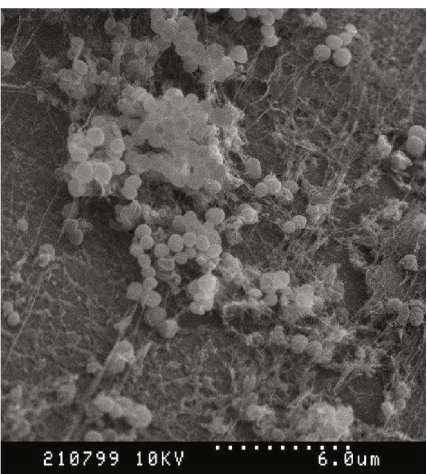
Figure 9: SEM image of methicillin-resistant Staphylococcus pseudintermedius bio fi lm formation on 316L stainless steel orthopedic bone screws. Dottedline = 6 μ m . Large aggregates of cocci and irregularly produced EPSs are apparent